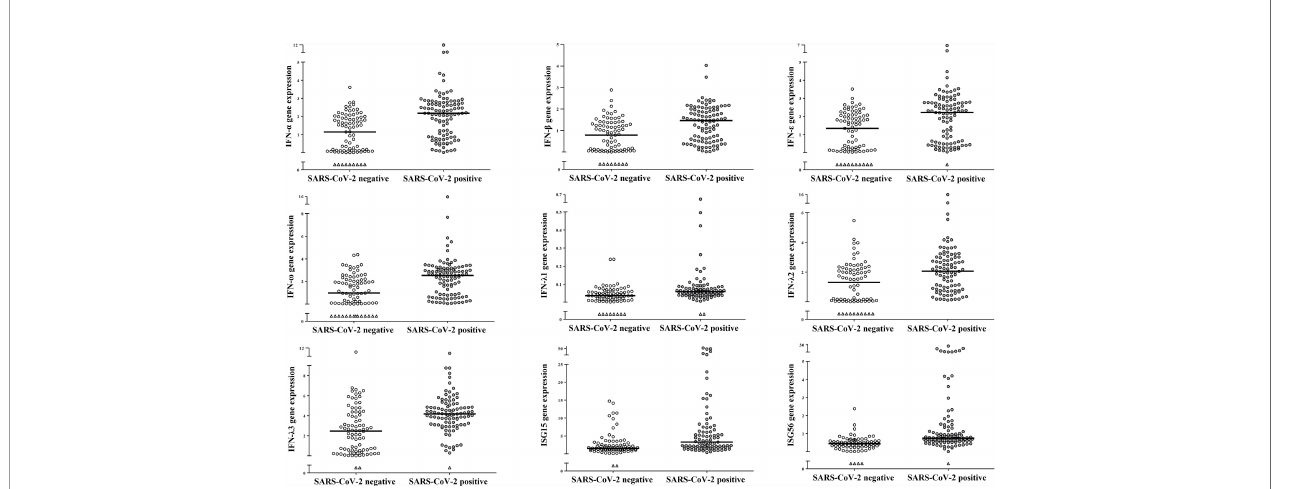
FIGURE 1 | SARS-CoV-2 infection induced activation of IFN genes in nasopharyngeal cells. Relative mRNA expression values (y-axis), calculated using the threshold cycle relative quanti fi cation (2 - D Ct ), are reported for each gene; values are depicted as open circles for SARS-CoV-2 negative- and as fi lled circles for SARS-CoV-2 positive samples, triangles indicate samples with Ct values >40. Horizontal lines indicate the median value of the group indicated below the X-axis. All p-values, calculated using Mann-Whitney tests for comparison of each gene between SARS-CoV-2 negative and positive samples, are